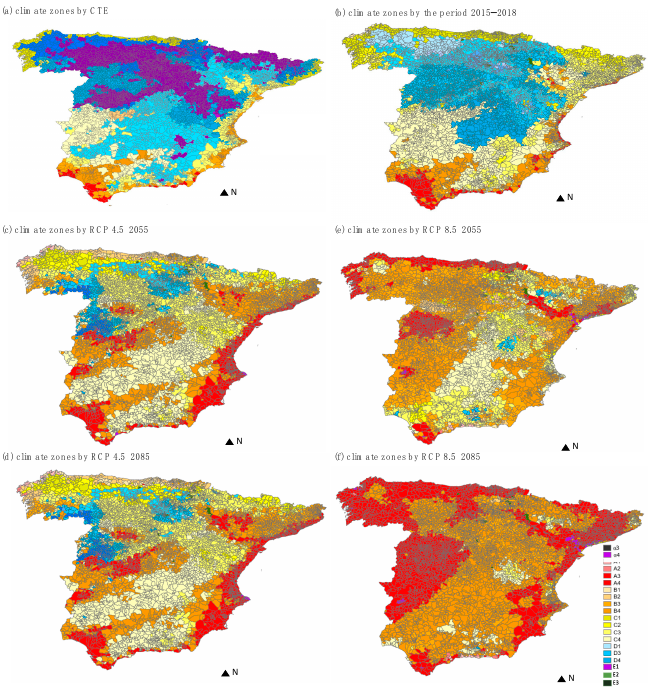
Figure 6. Maps of ( a ) CTE, ( b ) climatic zone by the period 2015–2018, ( c ) climate zones for RCP 4.5 2055, ( d ) climate zones for RCP 4.5 2085, ( e ) climate zones for RCP 8.5 2055, ( f ) climate zones for RCP 8.5 2085.